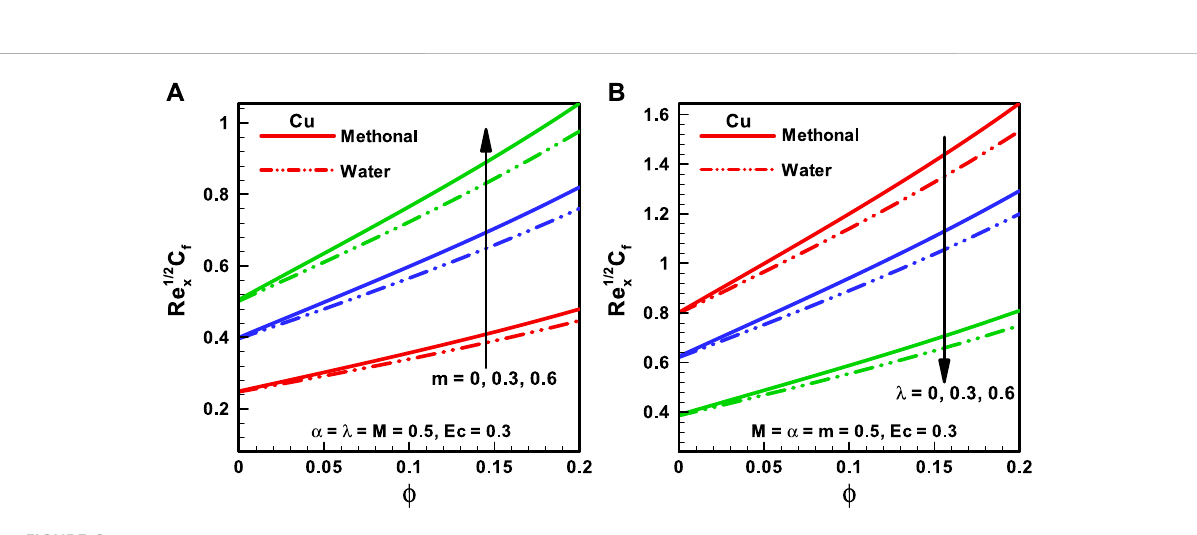
FIGURE 6 (A,B) Skin friction coef fi cient corresponding to different base fl uids, that is, water and methanol for (A) wedge parameter ( m ) and (B) moving wedge parameter ( λ